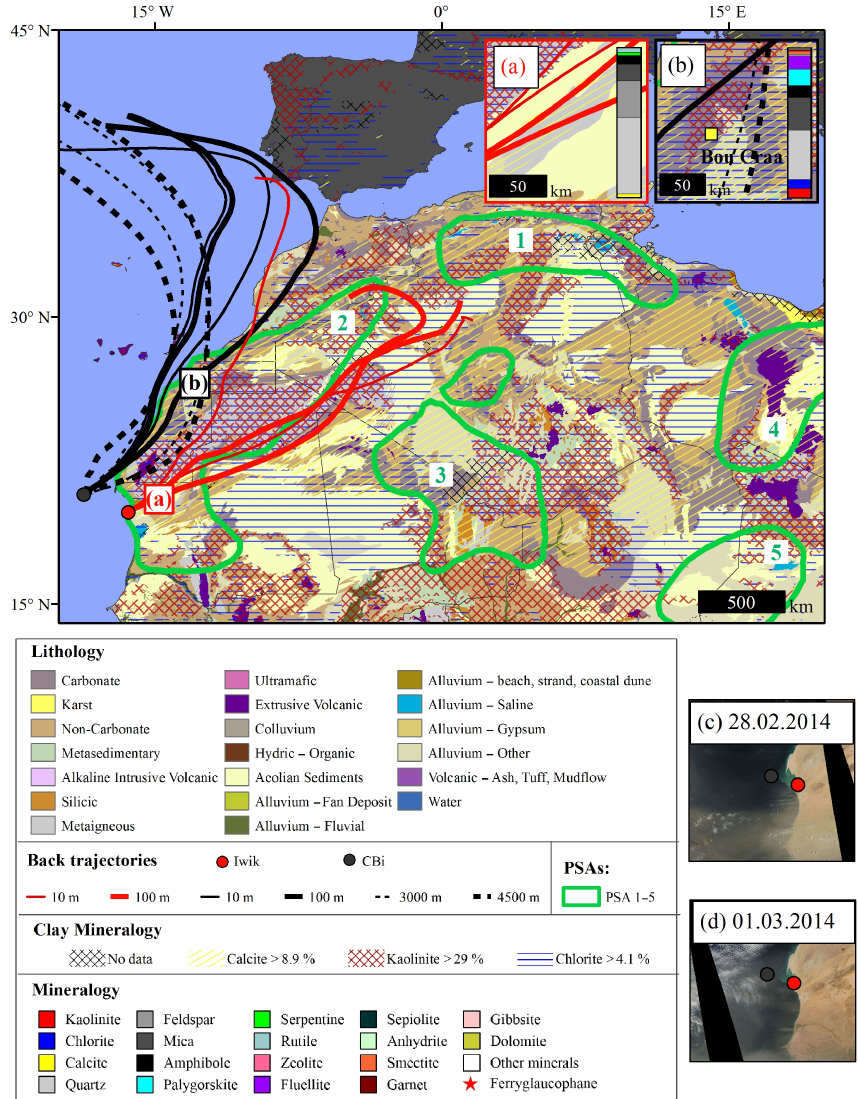
Figure 9. Low-level (10m) 4-day back trajectories of dust events ending during the sampling interval 15 February–15 March 2014 at site Iwik and during the sampling interval 26 February–18 March 2014 at site CBi. The potential dust source areas and the mineralogy of the samples are given in the panels (a–b) . The dust storm events occurring during the sampling interval are indicated in panels (c–d)